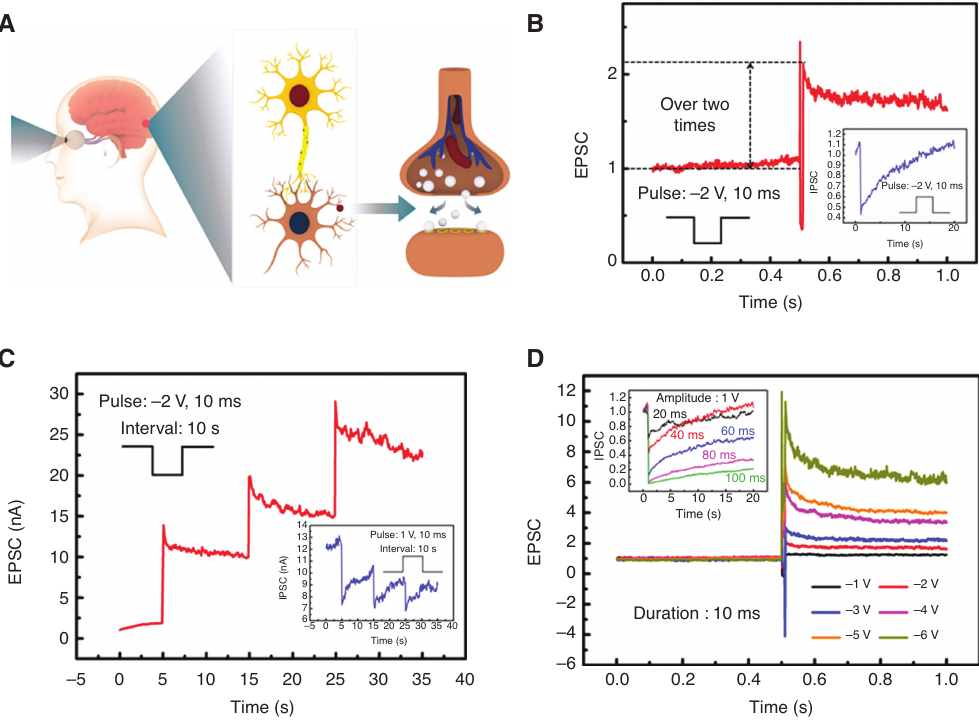
device. Figure 4: Synaptic performance of the MoS 2 (A) Schematic of the human optic nerve system and a biological synapse. (B) The EPSC triggered by the input pulse (−2 V, 10 ms). Inset: the IPSC triggered by a presynaptic spike (2 V, 10 ms). (C) EPSC triggered by three consecutive input pulses (an amplitude of −2 V, a duration of 10 ms, and an interval of 10 s). Inset: IPSC triggered by three consecutive input pulses (an amplitude of 1 V, a duration of 10 ms, and an interval of 10 s). (D) EPSC triggered by six individual pulses with 10-ms pulse width, but with amplitudes varying from −1 to −6 V in 1 V step. Inset: IPSC triggered by six individual pulses with 1-V amplitude but with pulse width changing from 20 to 100 ms in 20-ms